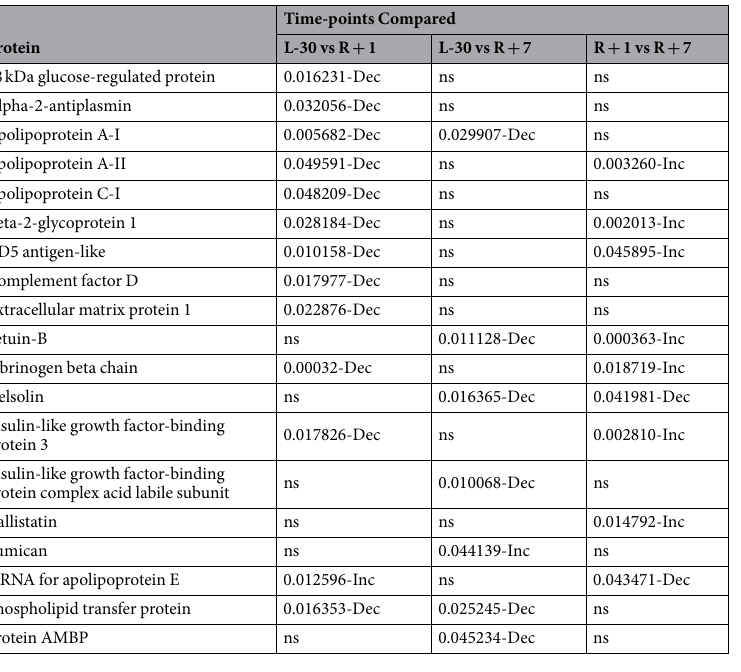
Table 1. P-values for proteins which show significant differences at the p < 0.05 level with the LSD Test. Notes to table: L-30–30 days prior to launch; R + 1 – the 1st day after landing; R + 7 – the 7th day after landing; Inc – increased level; Dec – decreased level; ns – no significant